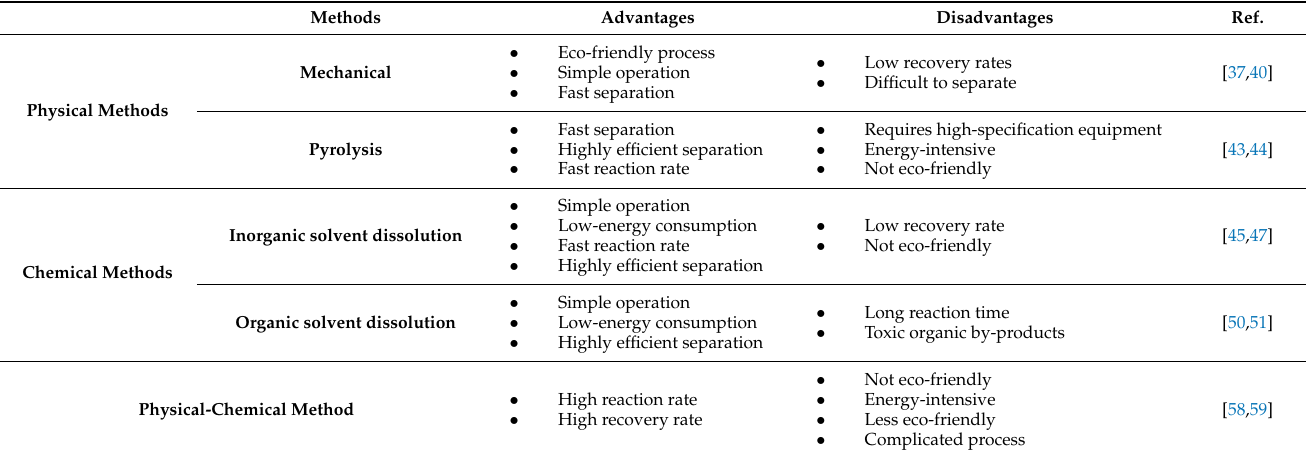
Table 2. Key advantages and disadvantages of different EOL PVM recovery